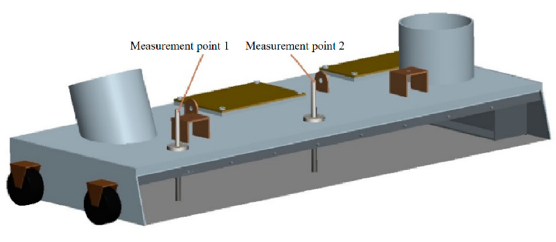
Figure 16. Location distribution of measurement point.